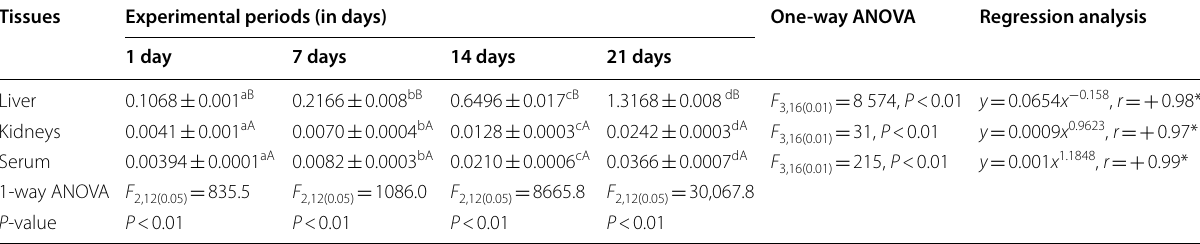
Table 4 The levels of aflatoxin B (AFB ) accumulated in the liver, kidney (ng/g), and serum (ng/ml) of rats given a subacute LD 1 1 AFB alone at 96 h ( 7.49 mg/kg b. wt., Group IV), every other day, throughout 21 days 1 ≡